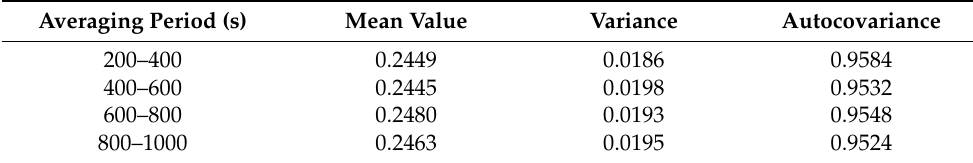
Table 2. Mean Value, Variance and Autocovariance for Specific Time